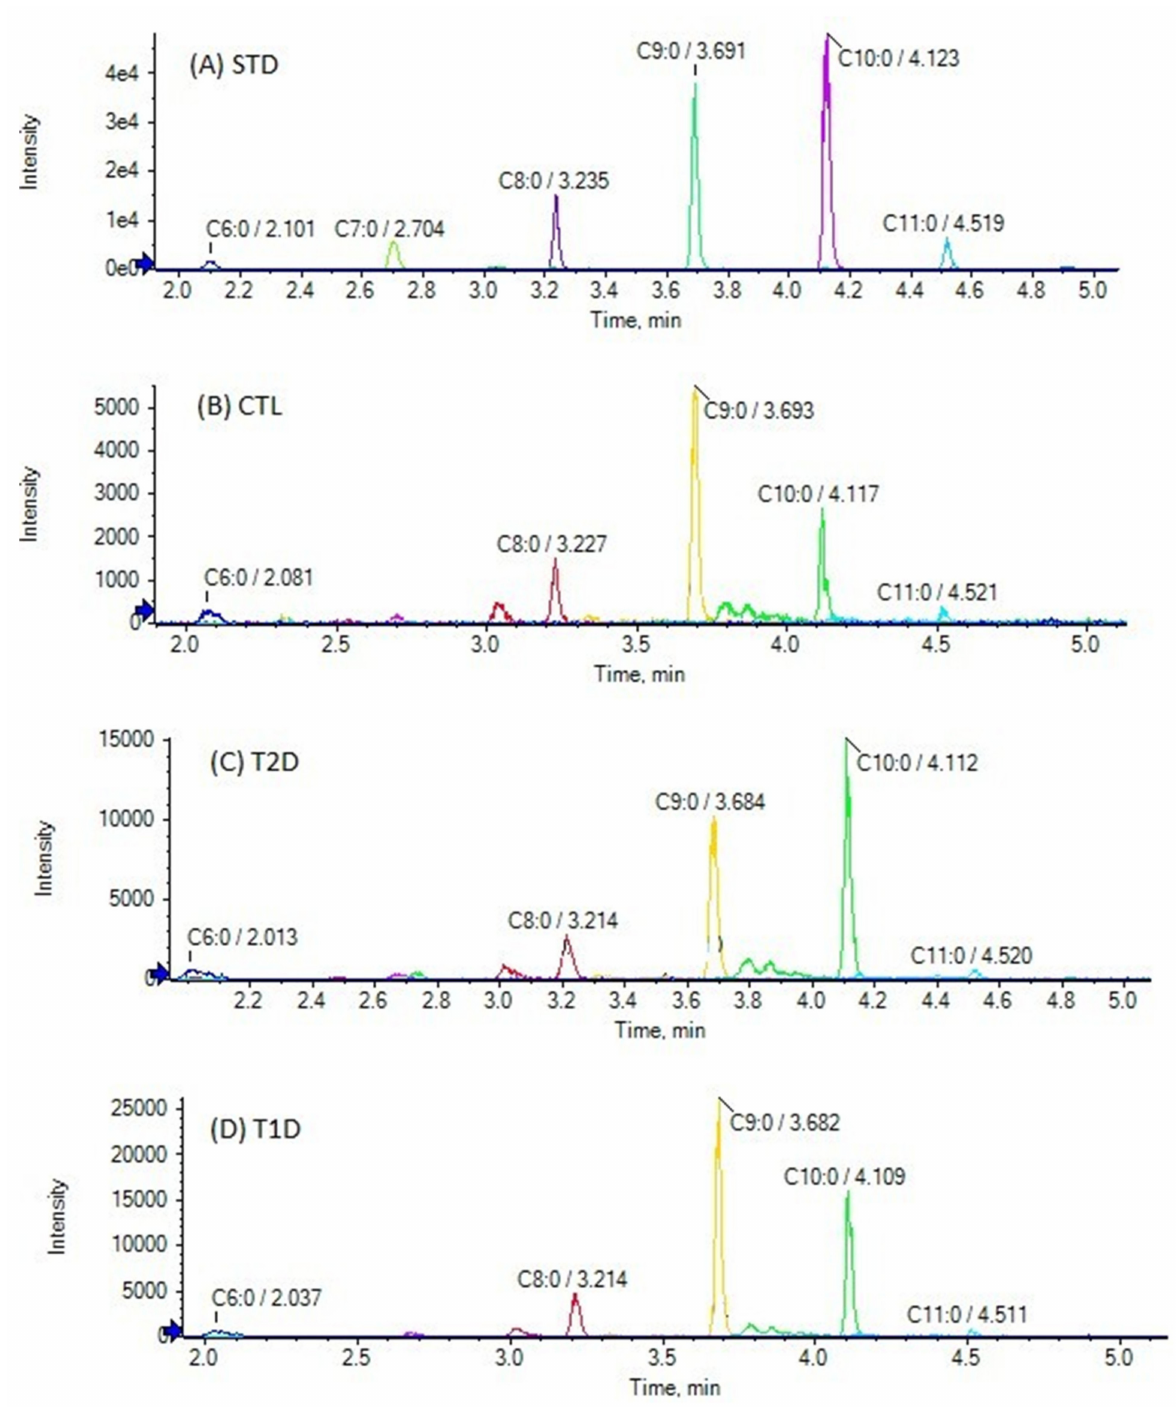
Figure 3. Extracted ion chromatograms (EICs) of medium-chain FAs (C6:0- C11:0) in a standard solution (500 ng/mL) ( A ), and in a representative control sample ( B ), a T2D sample ( C ), and a T1D sample ( D ). The long-chain saturated odd-chain FA C17:0, as well as the unsaturated C18:3, C20:4, C22:4 and C22:5 were estimated at mean values of 2.94 ± 2.66 nmol/mL, 1.16 ± 0.45 nmol/mL, (Table 3). Several other long-chain FAs were quantified at concentrations lower